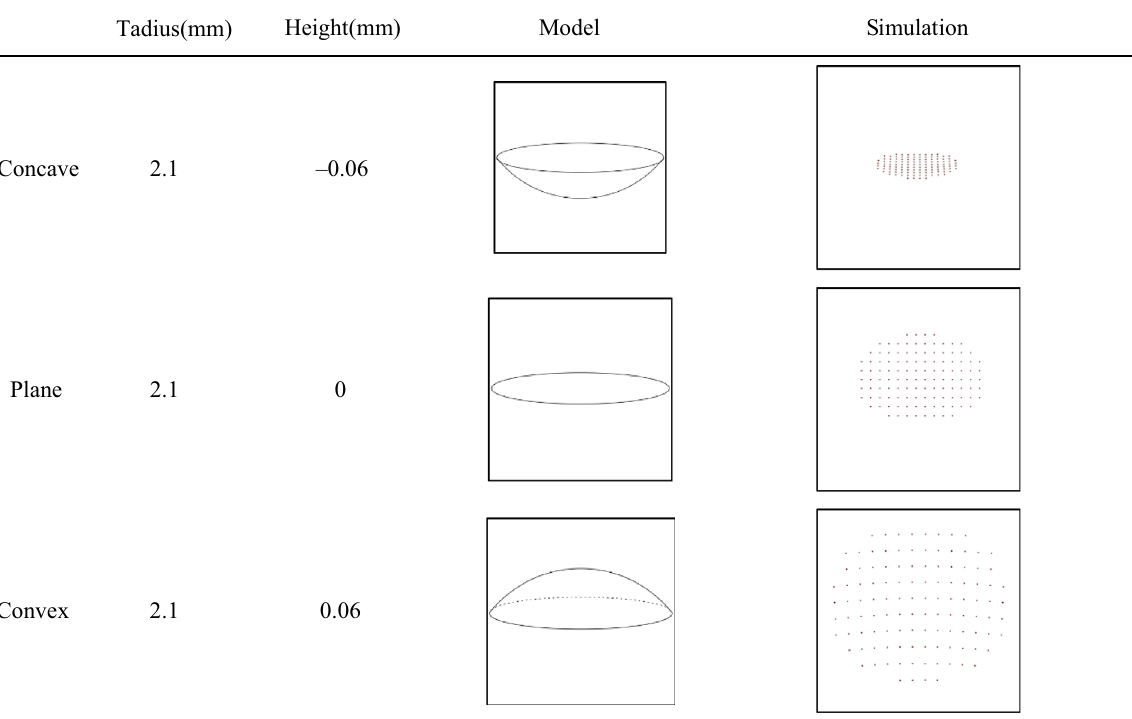
Table 3 Simulation parameters and